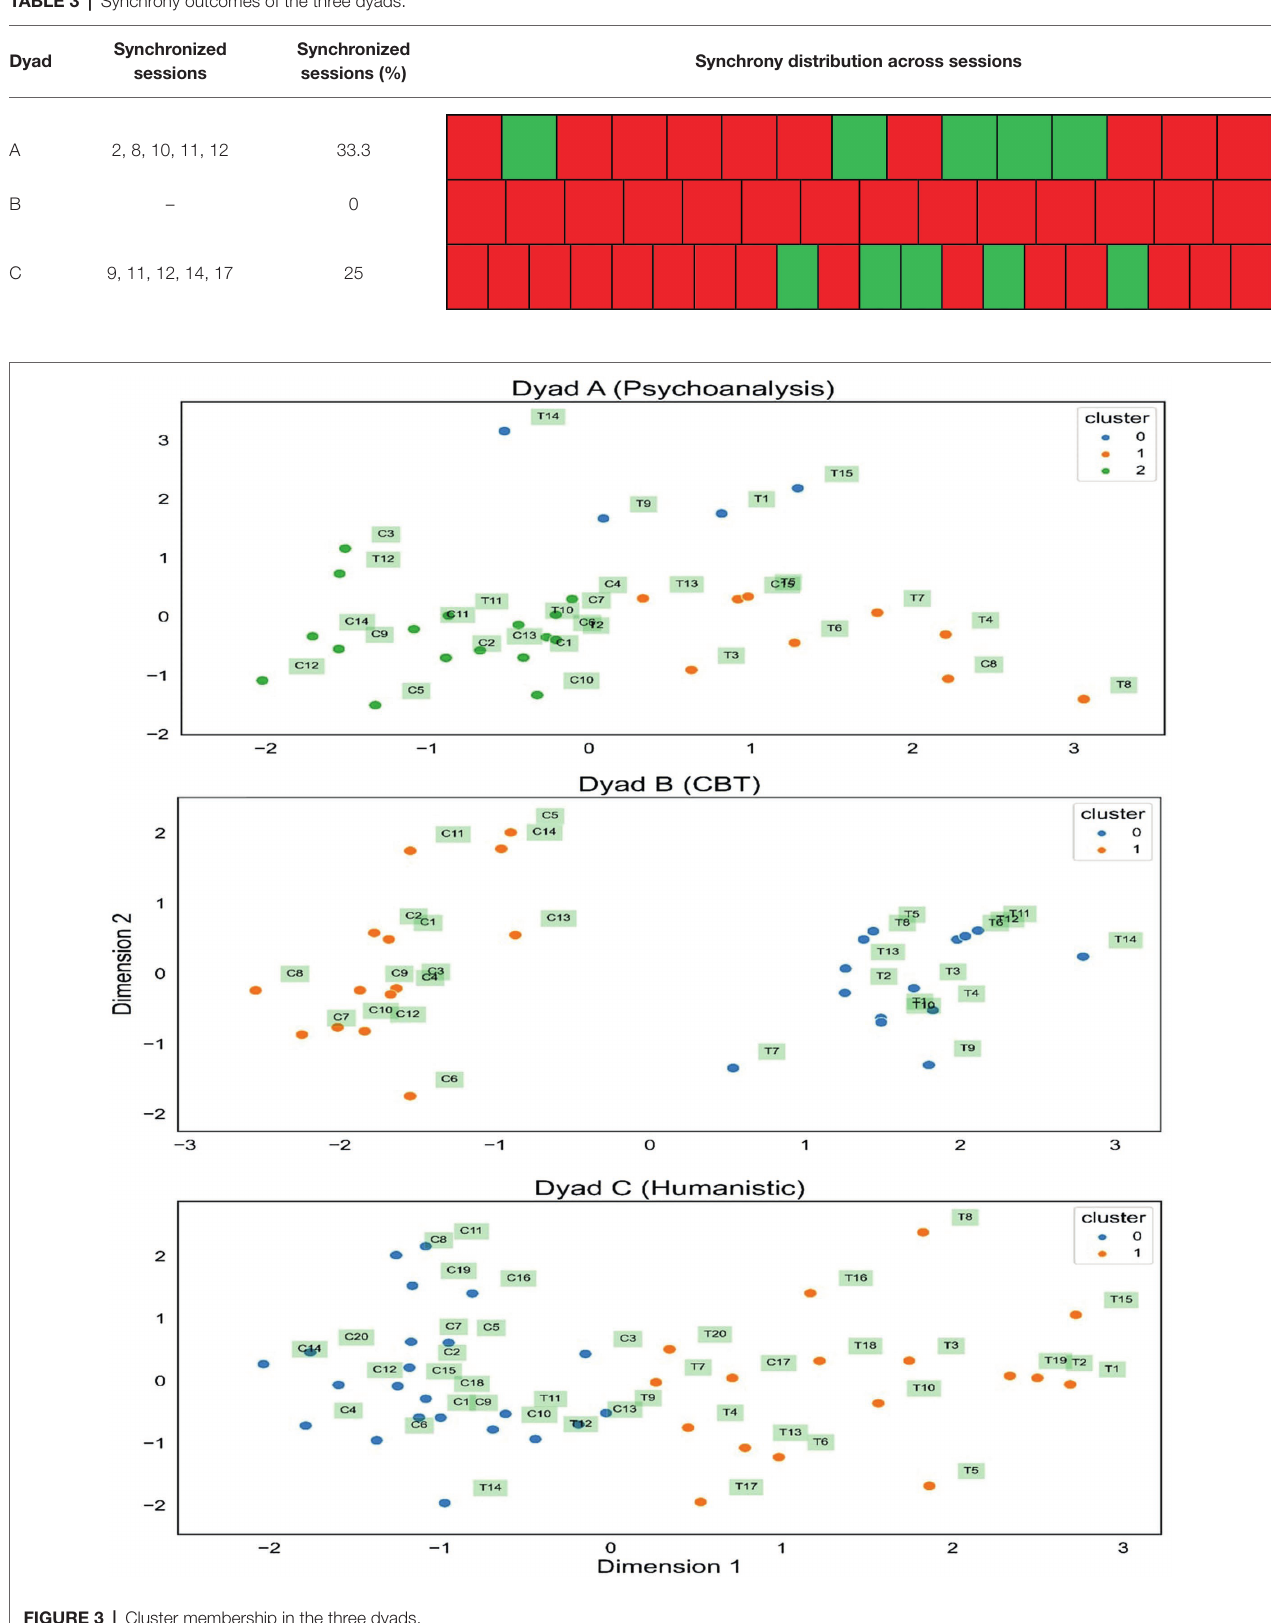
TABLE 3 | Synchrony outcomes of the three dyads.